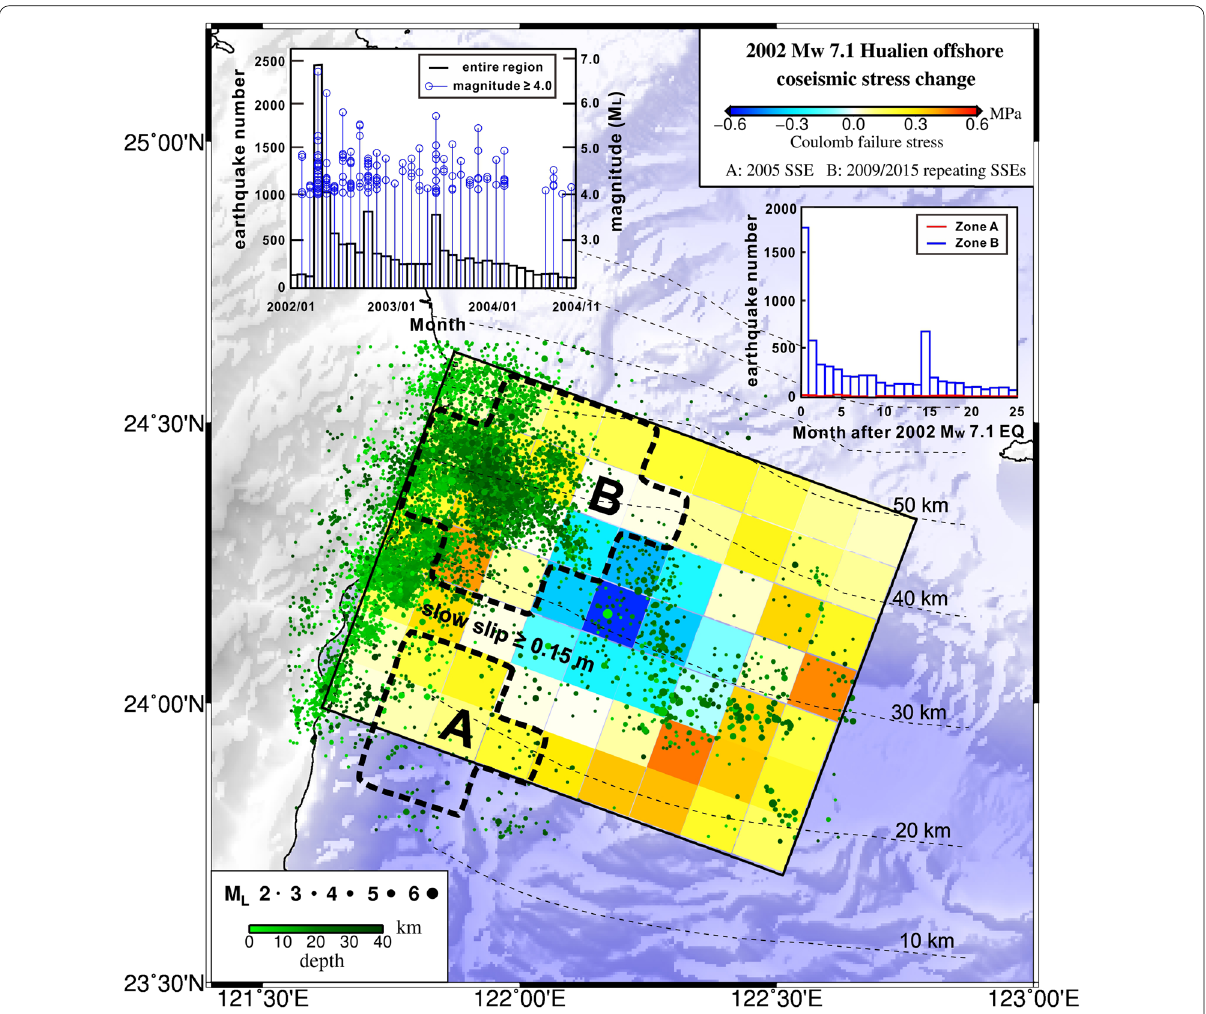
Fig. 5 Coulomb stress change and aftershocks following the 2002 M w 7.1 Hualien offshore earthquake. The aftershocks are shown by the green dots in the depths with different dot sizes for the magnitudes. The left top subfigure represents the aftershock evolution in the entire fault region. The histograms are the number of aftershocks per month. Only magnitudes greater than M L 4.0 are shown (circles). The right top subfigure represents the aftershock evolution only in the two SSE